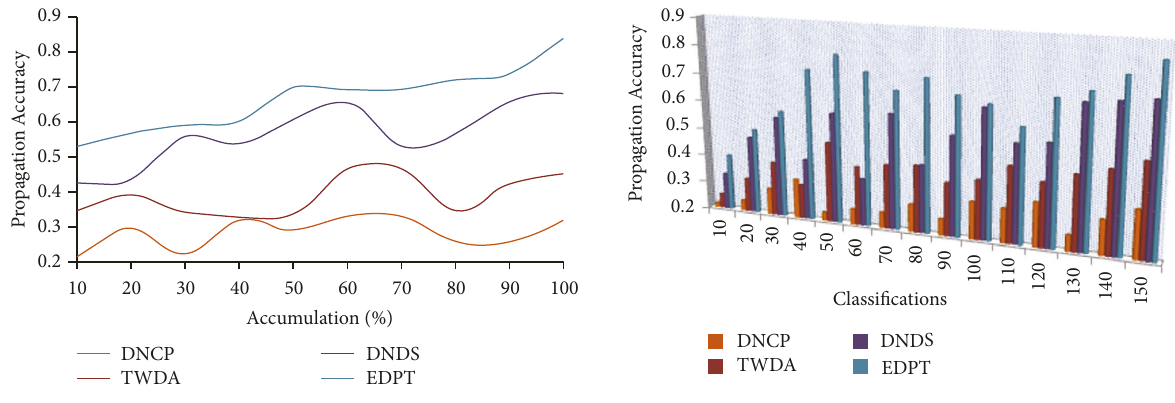
Figure 7: Propagation